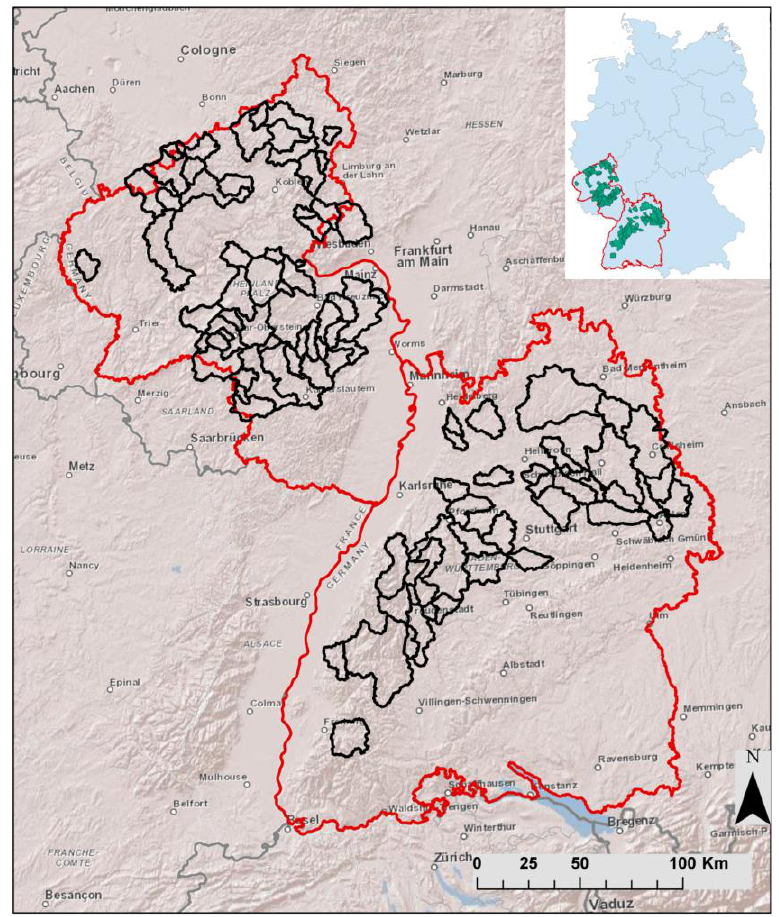
Figure 1. Catchments (black lines) of the study area in western Germany (red lines: federal states of Rhineland-Palatinate and Baden-Württemberg). Nested basins are sorted by size: smaller catchments are plotted on top of larger ones so that only headwater basins are displayed completely.